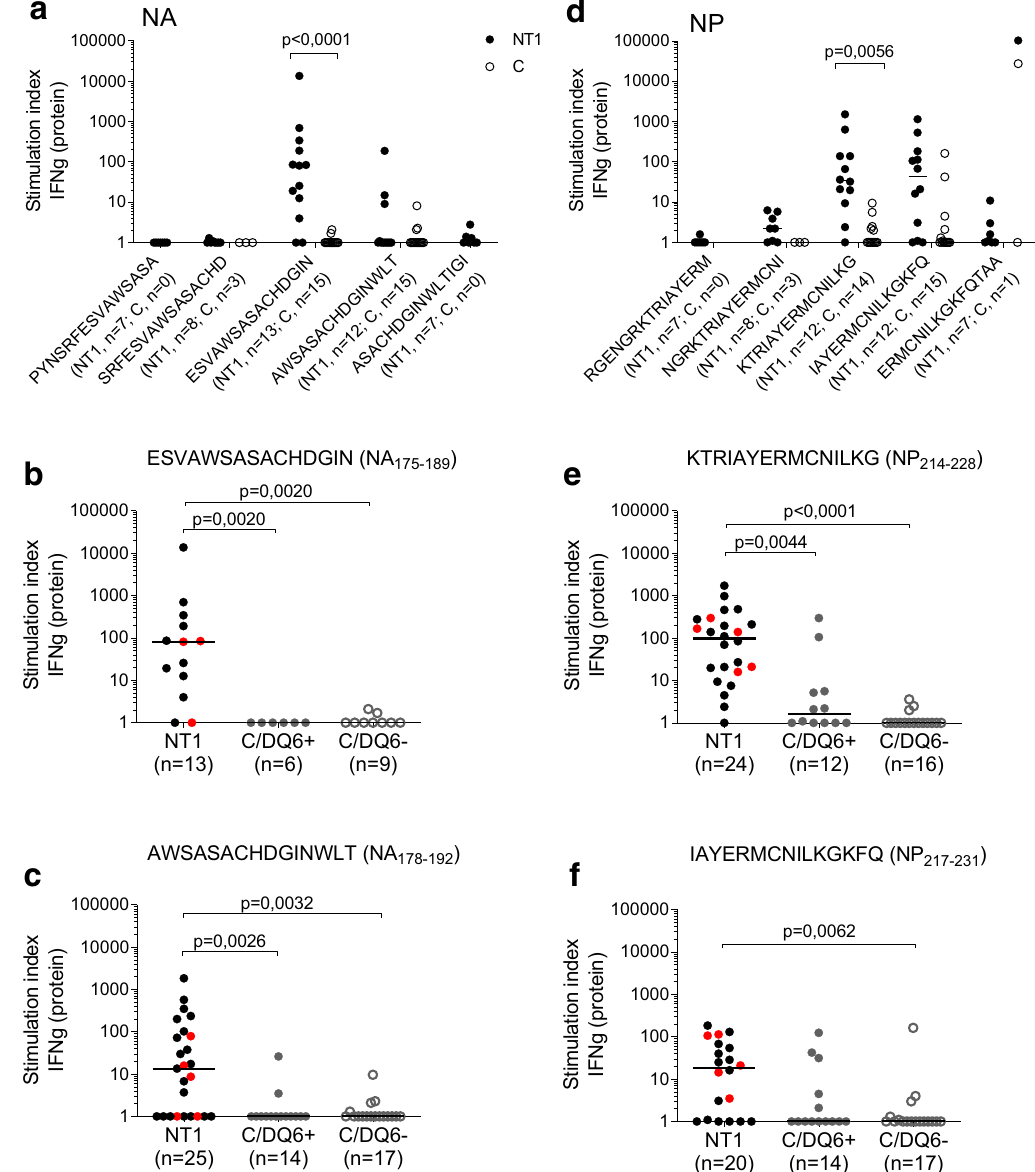
Fig. 4 Mapping of identi fi ed in fl uenza A H1N1 virus T-cell epitopes in Pandemrix-associated NT1 patients. a , d PBMC from pediatric Pandemrix- associated NT1 patients (NT1; validation cohort) or pediatric Pandemrix-vaccinated healthy controls (C) were stimulated in culture with overlapping 15-mer peptides from in fl uenza (A/reassortant/NYMC X-179A (California/07/2009 × NYMC X-157)(H1N1)) vaccine virus neuraminidase (NA) or nucleoprotein (NP), as indicated. b , c , e , f PBMC from NT1 patients (invariably HLA-DQB1*0602 positive; discovery and validation cohorts combined; HLA-DQB1*0602 homozygous NT1 patients marked with red dots) or HLA-DQB1*0602 positive (C/DQ6 + ) or negative (C/DQ6 − ) healthy controls were stimulated with single NA- or NP-derived peptides. The secretion of IFN- γ was measured by FMIA (protein). Results are expressed as the ratio between cytokine concentrations measured in peptide-stimulated and negative control samples (stimulation index). Statistical comparisons between groups were performed, using Kruskal – Wallis and Dunn ’ s multiple comparisons clones using TRAV10/TRAJ17 or TRAV10/TRAJ24 gene seg- ments. This indicates that these clonotypes are likely involved in the pathogenesis of NT1.